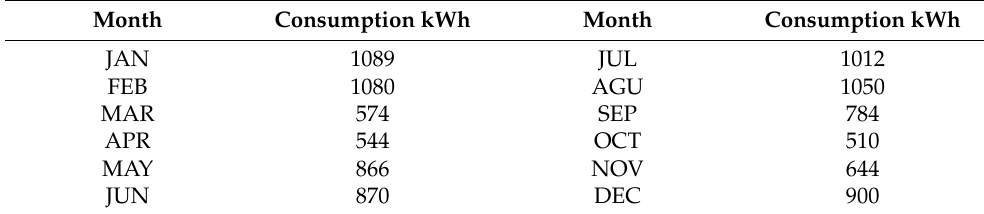
Table 2. An example of monthly electricity demand over 2019 for a single house.